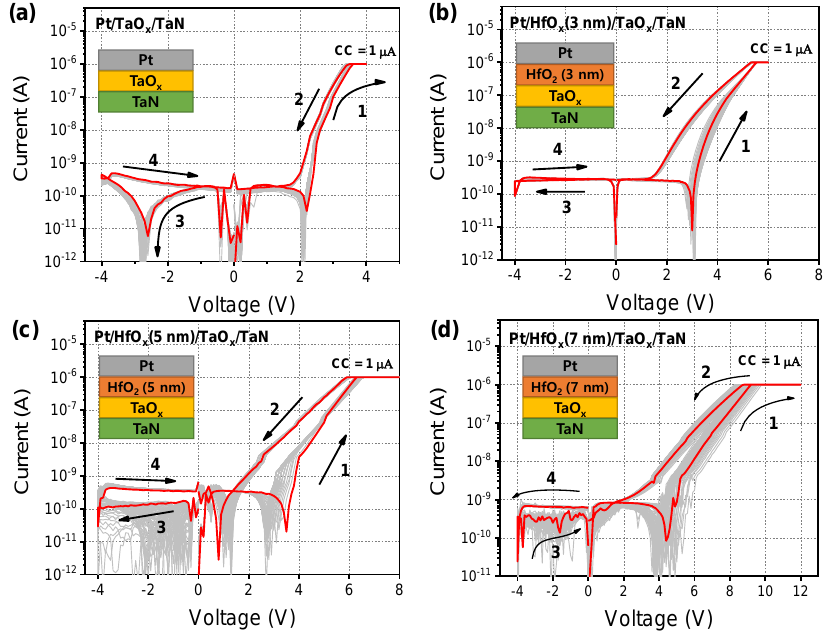
Figure 3. I–V characteristics of four devices: ( a ) PTT, ( b ) PHTT3, ( c ) PHTT5, ( d ) PHTT7. Schemes of the device are shown as the inset.